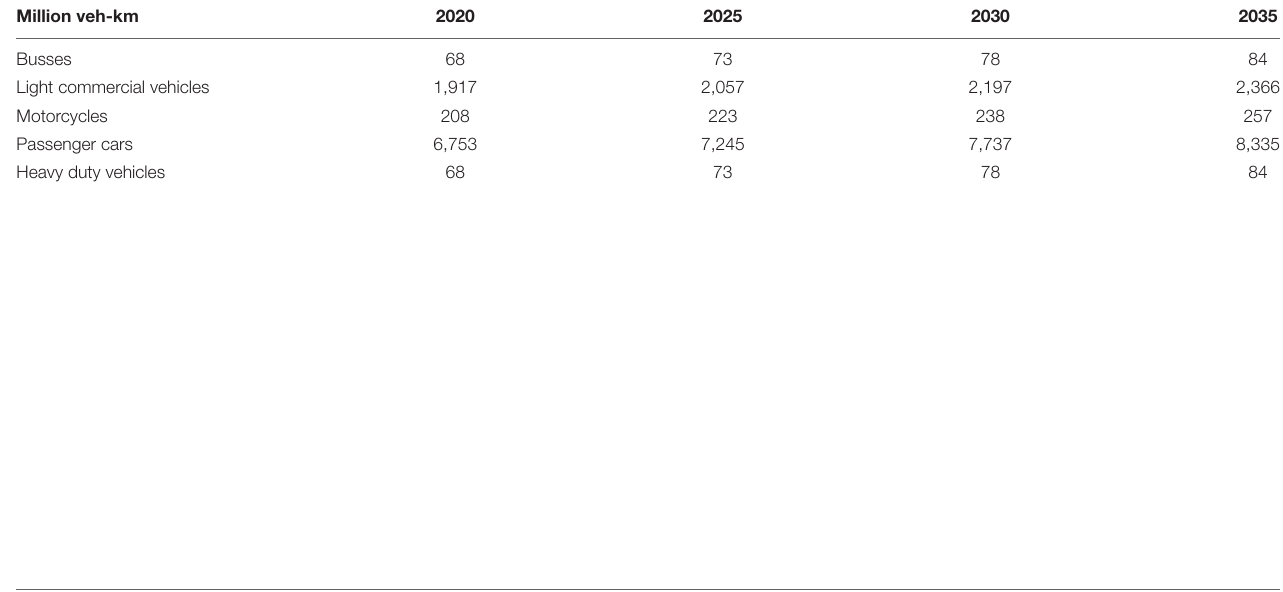
TABLE A4 | Fuel efficiency projections